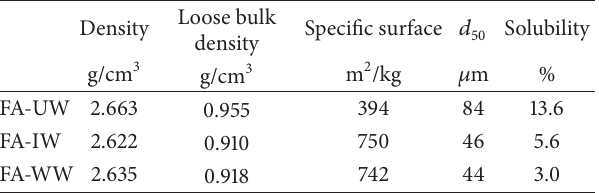
Table 5: Fundamental physical properties of FA-UW, FA-IW, and FA-WW.